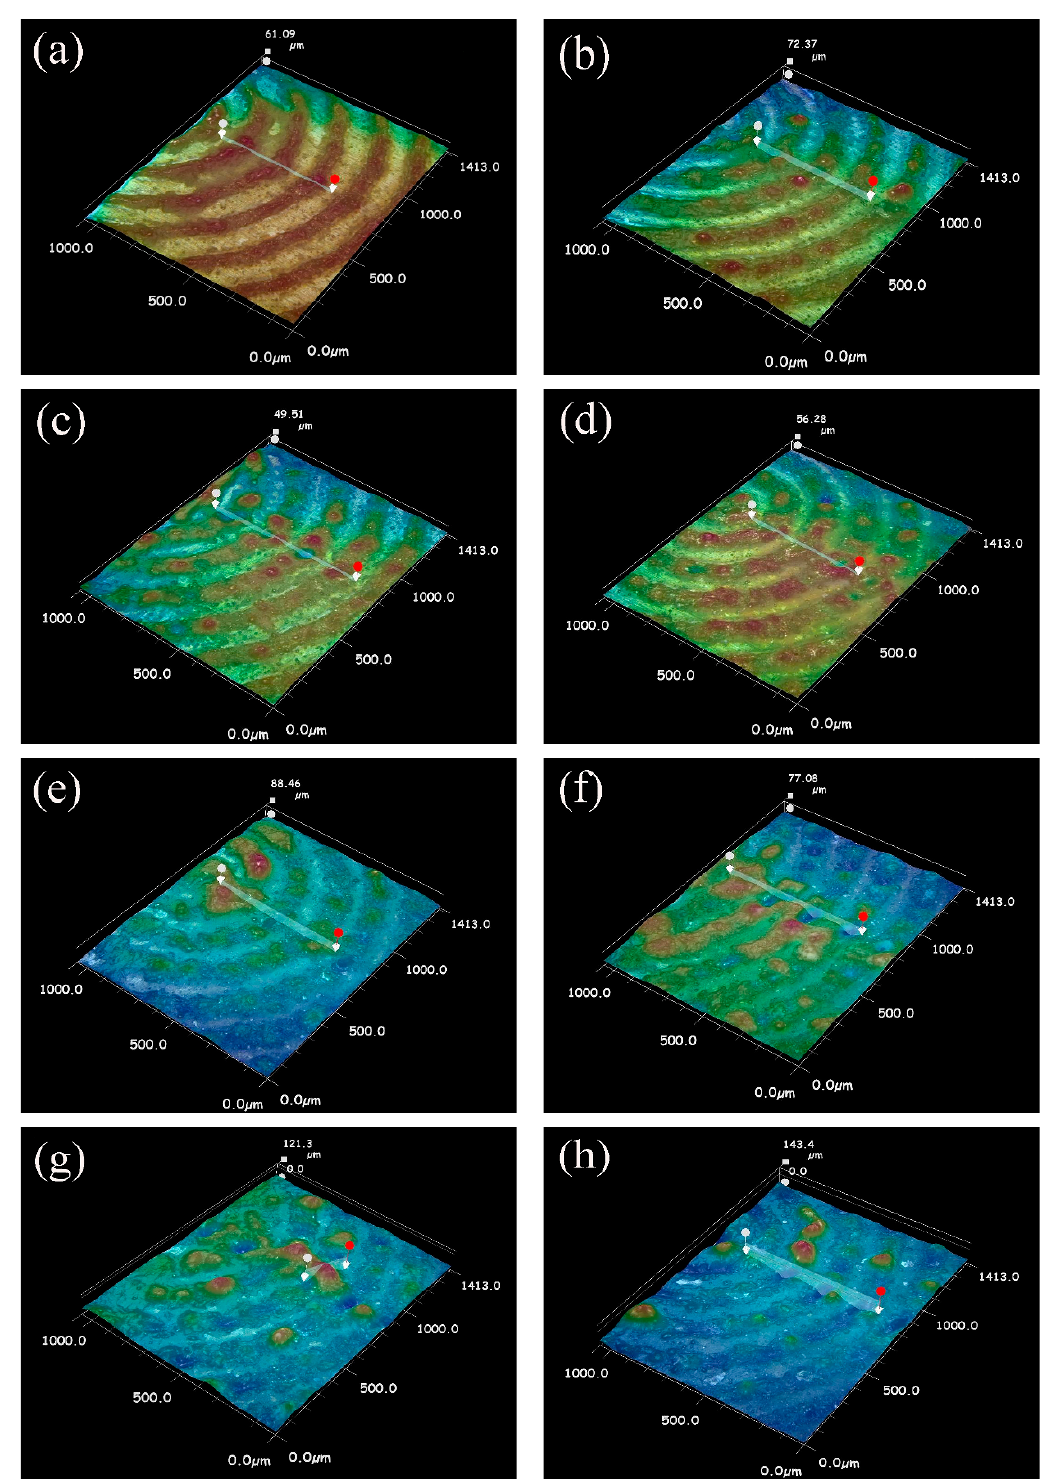
Figure 9. Optical three-dimensional surface morphology under different power ( a ) 15 W, ( b ) 20 W, ( c ) 25 W, ( d ) 30 W, ( e ) 35 W, ( f ) 40 W, ( g ) 45 W, ( h ) 50 W.